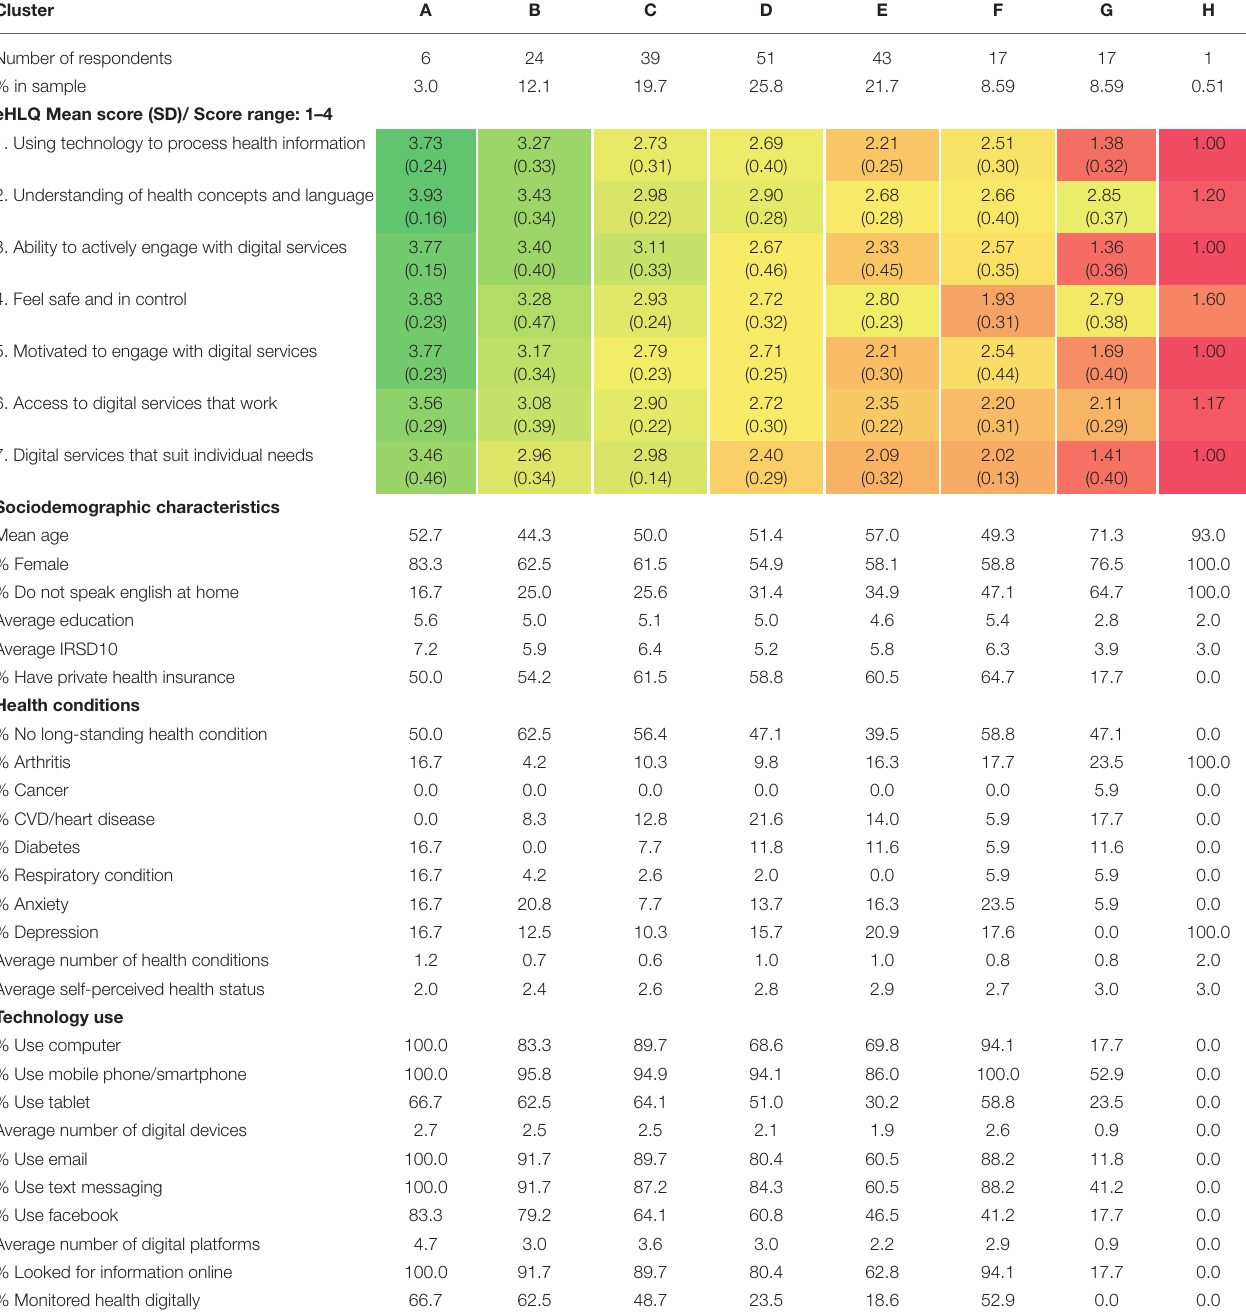
TABLE 4 | Example of and eHealth literacy profiles based on an eight-cluster solution for Site 1 respondents. Cluster A B C D F G